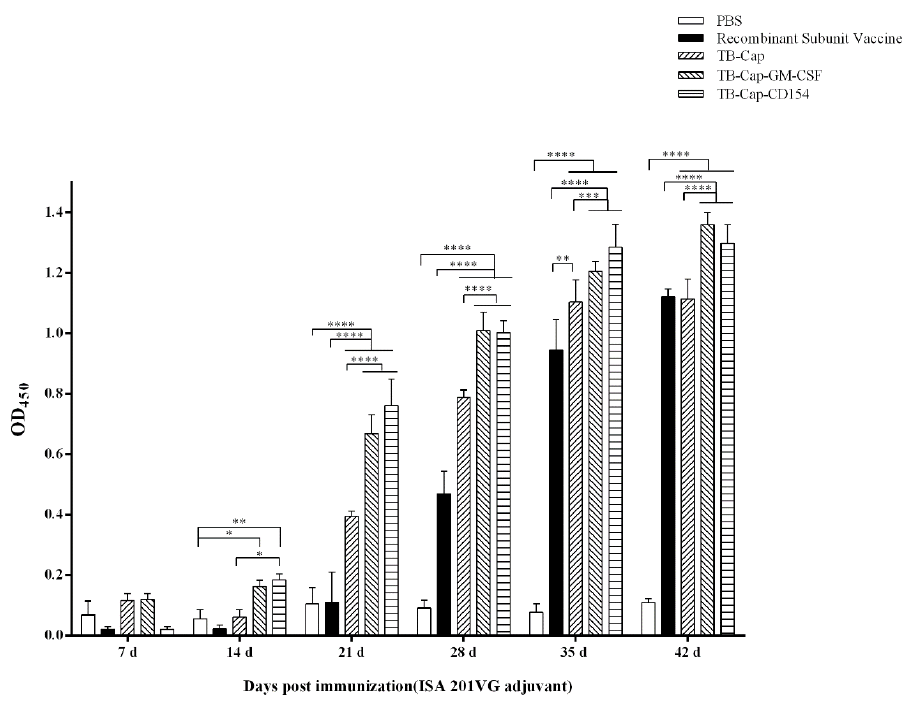
Figure 5. PCV2-specific humoral immune responses in different groups. All mice in the immunization groups were immunized again on the days 14 and 28 after the first immunization. Serum samples were collected on days 0, 7, 14, 21, 35, and 42 after first immunization and the serum antibody levels were detected by indirect ELISA. The cutoff value of S/P ratio is 0.2. d: day. Data represent the mean ± SD. An asterisk (*) shows a statistically significant difference between the indicated groups ( p < 0.05). (*): p < 0.05; (**): p < 0.01; (***): p < 0.001; (****): p < 0.0001.